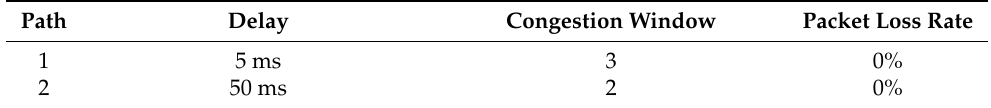
Table 1. Example network configuration.